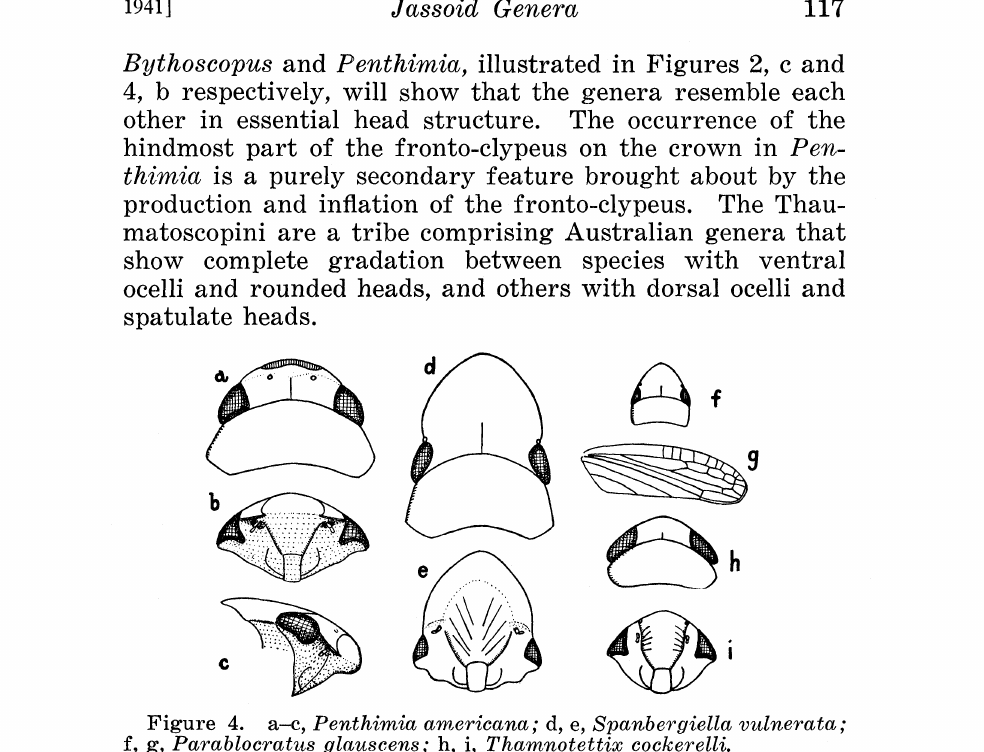
Figure 4. a-c, Penthimia americana; d, e, Spanbergiella vulnerata; f, g, Parablocratus glauscens h, i, Thamnotettix cockerelli.